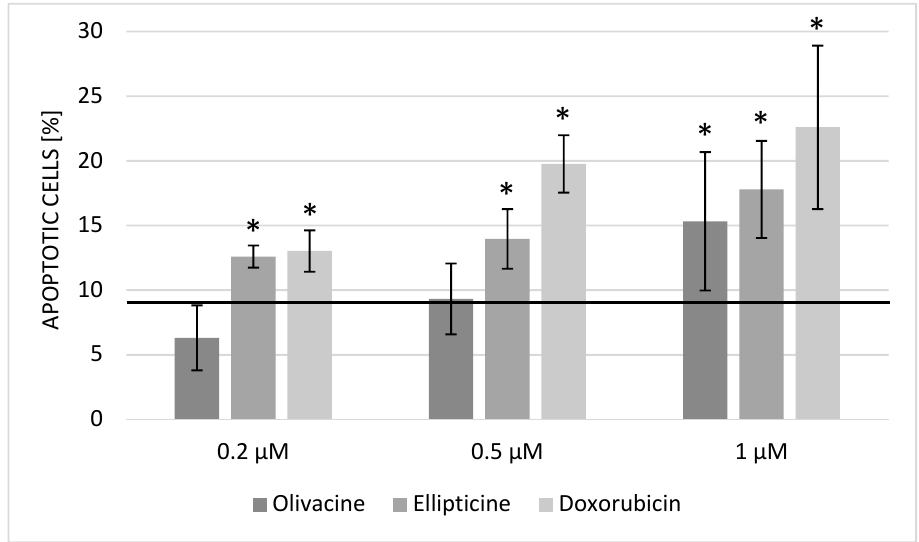
Figure 2. Rate of apoptosis after 24 h incubation with olivacine, ellipticine, or doxorubicin. Apoptotic cells in the control culture: 8.59 ± 0.97%. Statistical significance calculated with t -test (* p < 0.05).